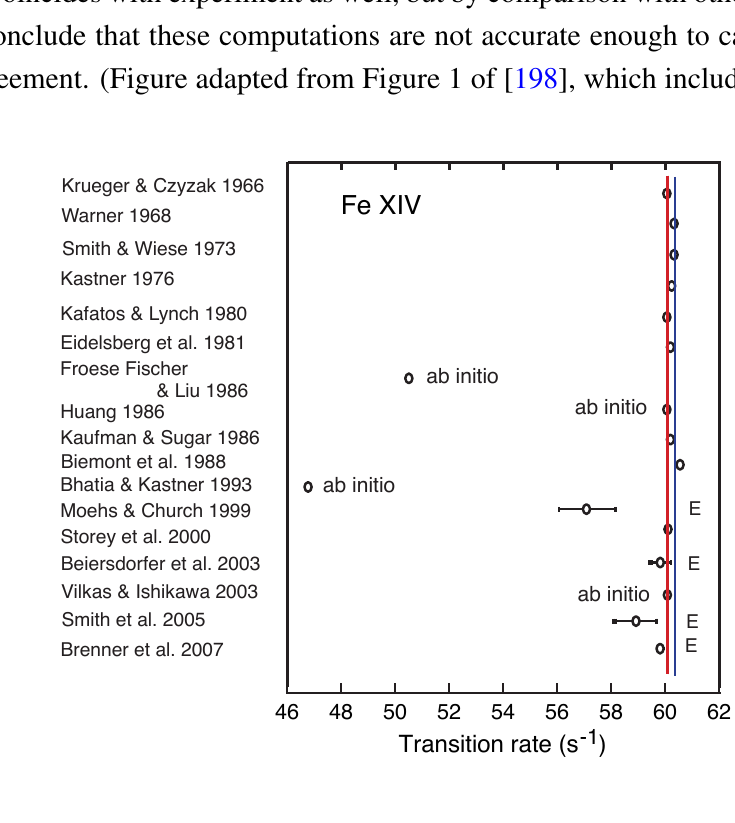
Figure 11. Timeline of the transition rate of the ground state fine structure transition in the Al-like ion (Fe 13+ of iron. The four experimental data points result from two experiments with an electrostatic ion trap and from two that used EBITs. In the latest one [205] the error bar is smaller than the symbol size. The vertical red line (left one of the pair) shows the result of naive theory combining the experimental transition energy and the single-configuration picture line strength. The accompanying dark blue line indicates the same expectation, but corrected for the EAMM contribution from quantum electrodynamics (QED). Note that the best experimental data point does not agree with what presently is seen as a correct theoretical prediction. All of the non- ab initio computations fall close to these two lines, because they have been adjusted to the experimental transition energy. Of the four ab initio computations only one (MR-MP) [199] coincides with the range of successful experiments by merit (and still misses the EAMM correction). The computational result provided by Huang [67] coincides with experiment as well, but by comparison with other atomic